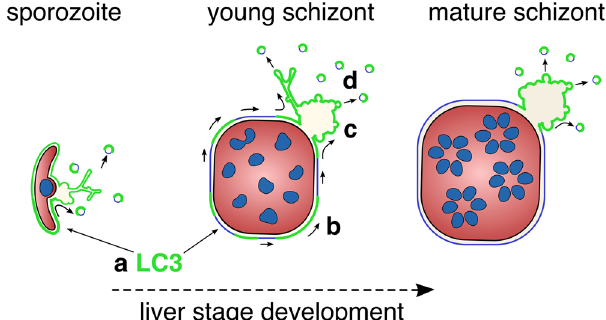
Figure 6. Model of the putative shedding mechanism during the hepatic stage of P. berghei . Progressive removal of PVM-associated LC3 during the P. berghei liver stage development. (a) LC3 incorporation into the PVM, (b) accumulation into PVM-patches, (c) transfer and entrapment in the TVN, and (d) vesicle shedding into the host